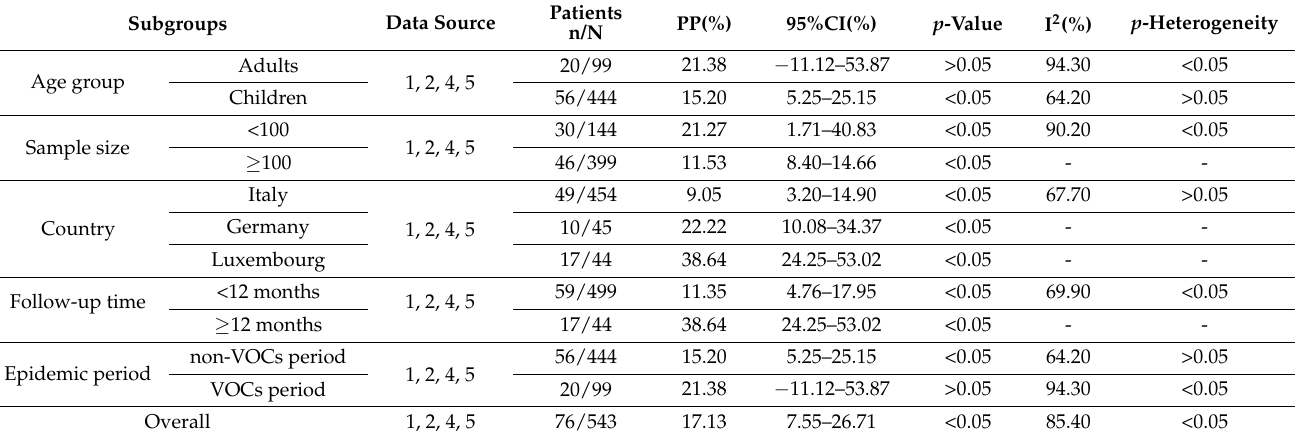
Table 2. Subgroup analysis of pooled prevalence (PP) of at least one symptom among asymptomatic SARS-CoV-2 infection cases by age group, sample size, country, follow-up time, and epidemic